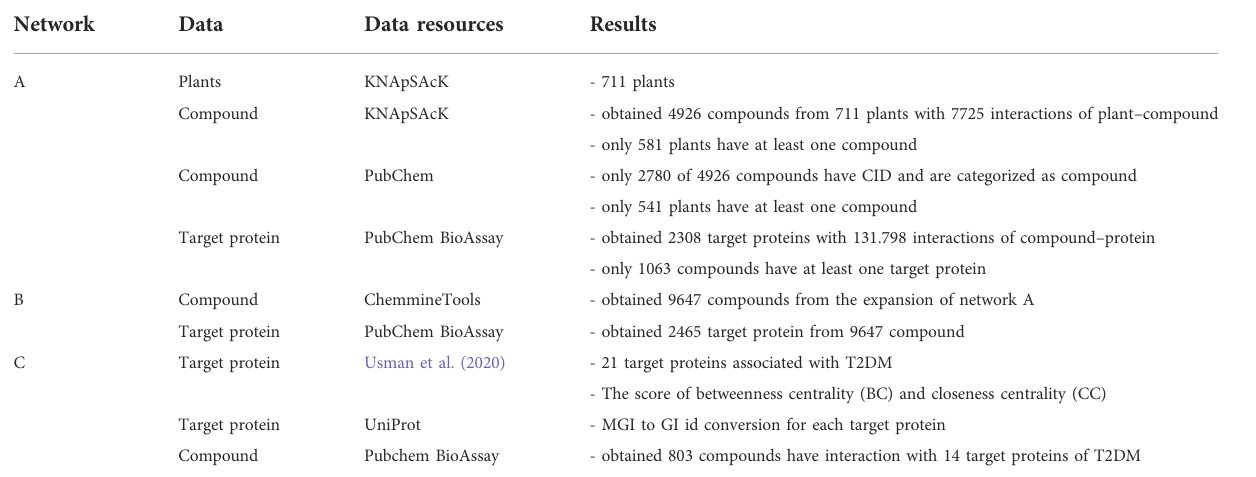
TABLE 1 Results of data acquisition from the various databases.